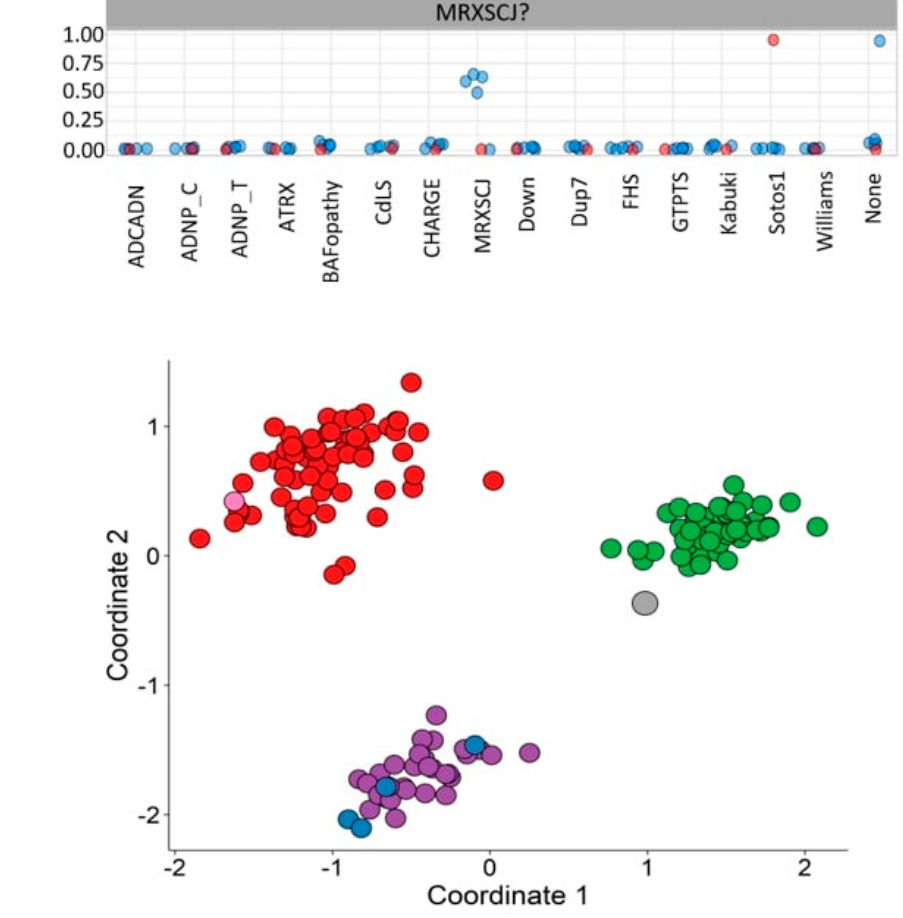
Figure 2. Classification of unresolved cases. ( A ) Six individuals suspected of having mental retardation, X-linked syndromic, Claes-Jensen-type (MRXSCJ) were supplied to the multi-class support vector machine (SVM) classifier. The methylation variant pathogenicity (MVP) scores generated by the model illustrate that 4 individuals are classified as cases of MRXSCJ, one as not having any of the 15 syndromes, and one (the red one) is classified as a Sotos syndrome 1 (Sotos1) case. ( B ) The multiple dimensional scaling (MDS) plot with MRXSCJ samples (purple circles), healthy control samples (green circles), and Sotos1 samples (red circles). This plot illustrates the clustering of four of the individuals described in panel A with the MRXSCJ case samples (blue circles) and two individuals separate from the MRXSCJ case samples. The grey circle represents the patient classified as not having any of the 15 syndromes, and the pink circle depicts the individual classified as a Sotos1 case.